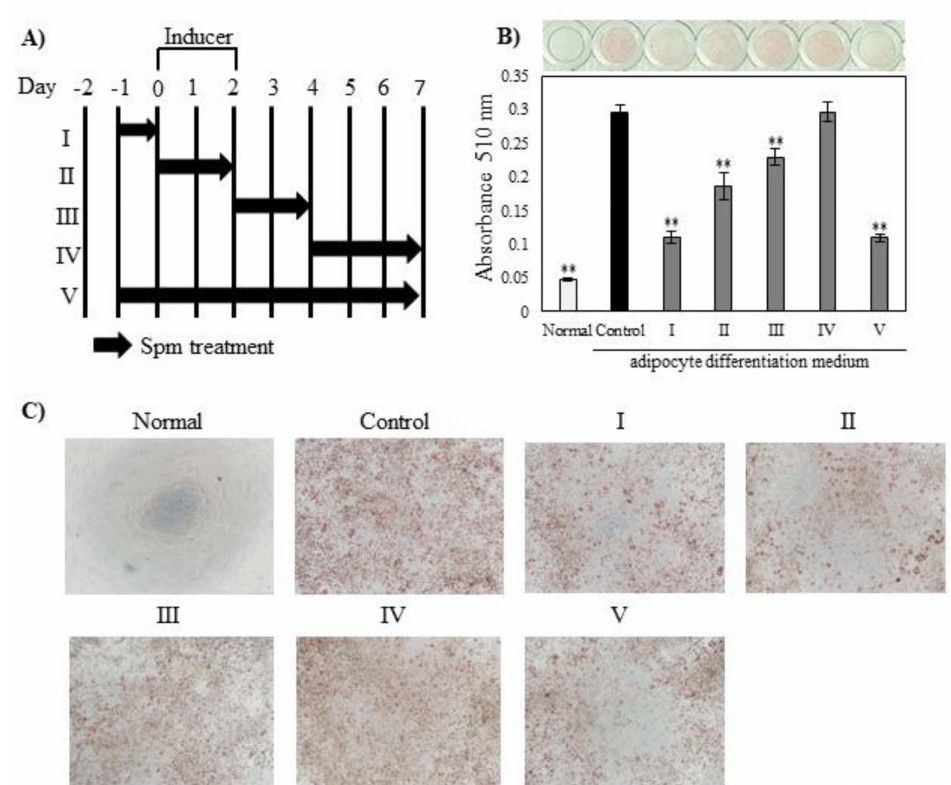
Figure 2. Spm inhibits differentiation of 3T3-L1 cells: ( A ) Description of Spm addition schedule; ( B ) Effect of Spm on lipid accumulation in 3T3-L1 adipocytes. Representative photographs showing cell monolayers stained with Oil Red O. ( C ) Images of treated cells obtained using an inverted microscope ( × 40). Red spots in images represent areas stained by Oil Red O. Data are presented as means ± S.E. derived from three independent experiments; each experiment carried out in 4 culture wells. Dunnett’s test, ** p < 0.01 vs.